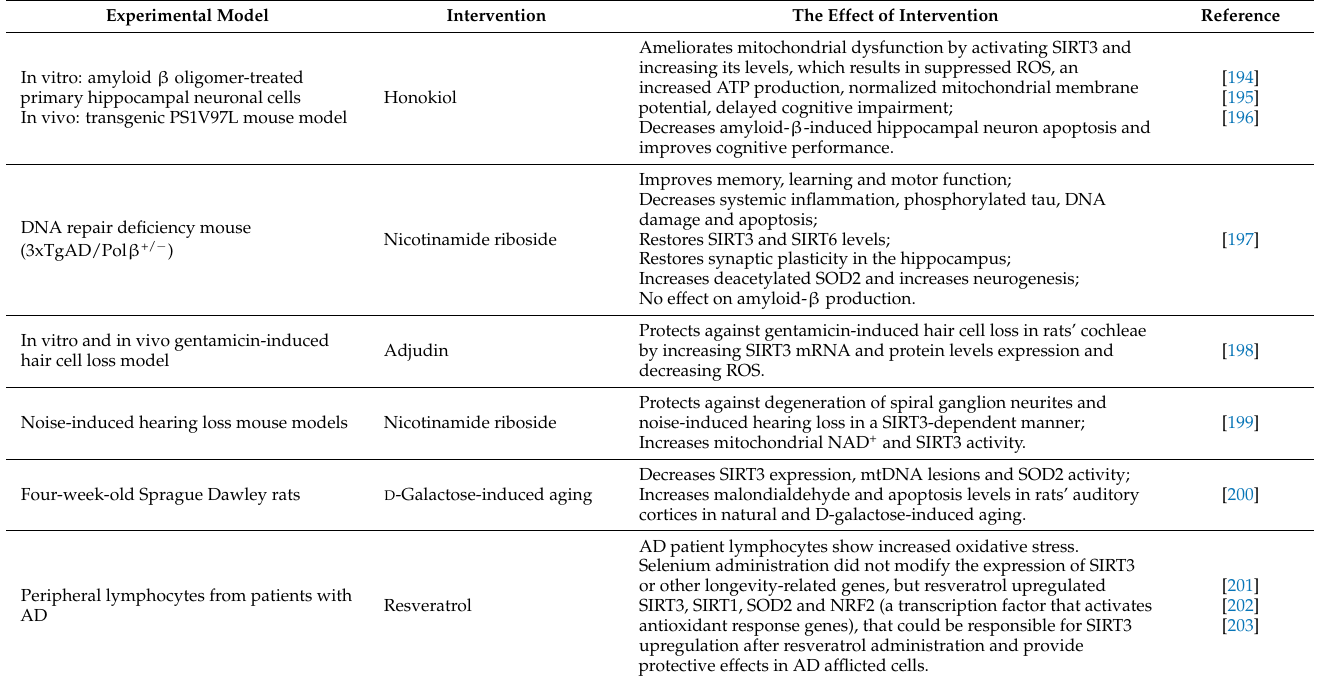
Table 3. Interventions that modulate SIRT3 signaling in age-related neurodegenerative diseases. Experimental